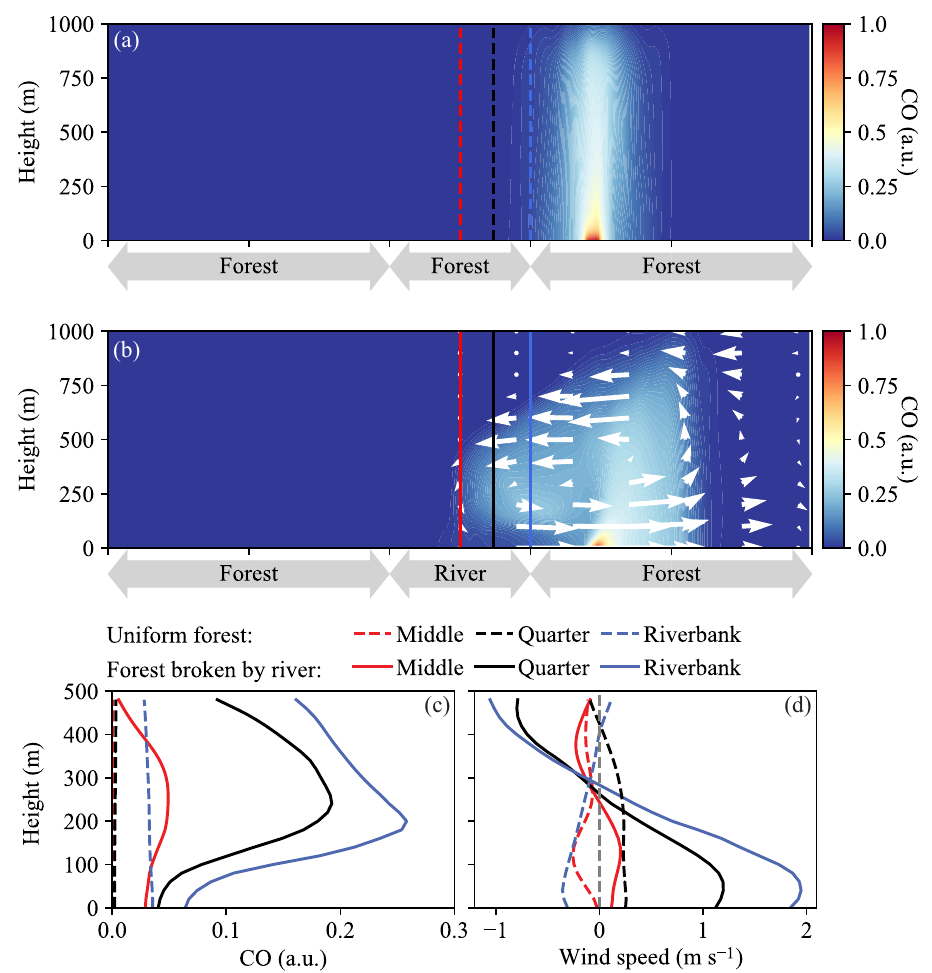
Fig. 4 Large eddy simulation (LES) representative of cluster 1. The simulation ran for 3 h, and the results were averaged over the last hour. a Forested landscape. b Forested landscape broken by a river of 5-km width. White arrows depict the simulated wind fi eld. c Vertical pro fi les of normalized CO concentration (CO, a.u.). Pro fi les over the riverbank, 25% across the river, and 50% across the river are represented by blue, black, and red lines, respectively. Dashed and solid lines represent the results for the landscapes of panels a and b , respectively. d Vertical pro fi les of wind speed (m s − 1 ). Positive values of wind speed represent a wind direction from the middle of the river toward the